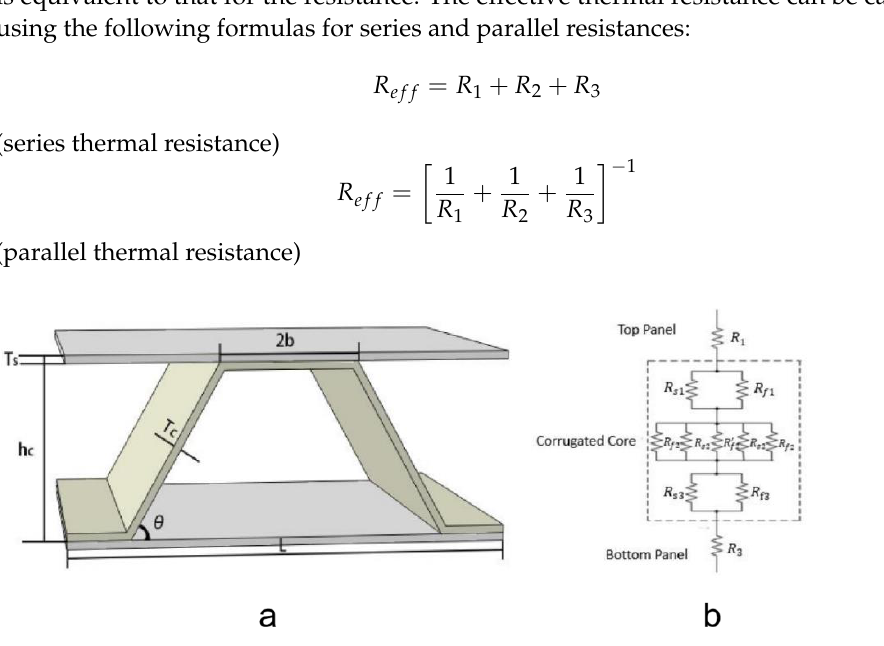
Figure 3. ( a ) Schematic diagram of corrugated plate structural elements. ( b ) Schematic diagram